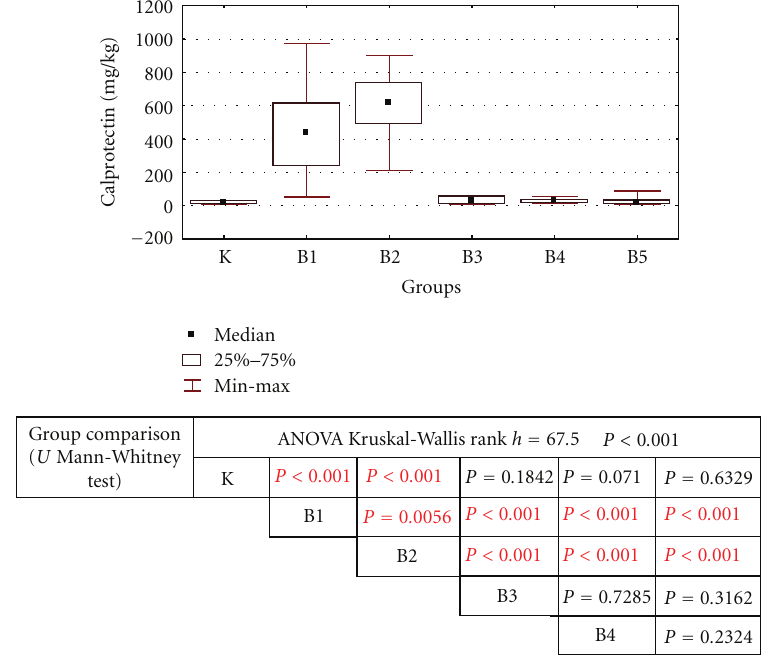
Figure 1: Comparison of faecal calprotectin concentrations among study groups.